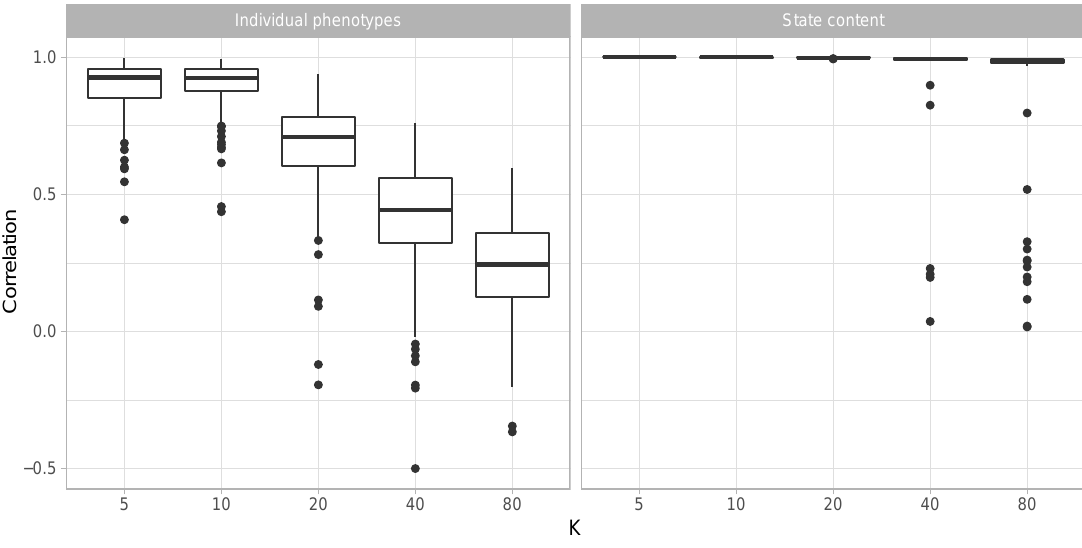
Figure 1. Correlations between simulated and fit phenotypes ( left ) and state contents ( right ). Both panels show boxplots, though for the state contents the values are concentrated enough that the hinges of the plots are not distinguishable. For phenotypes, each data point is an individual, while for states, each data point is a